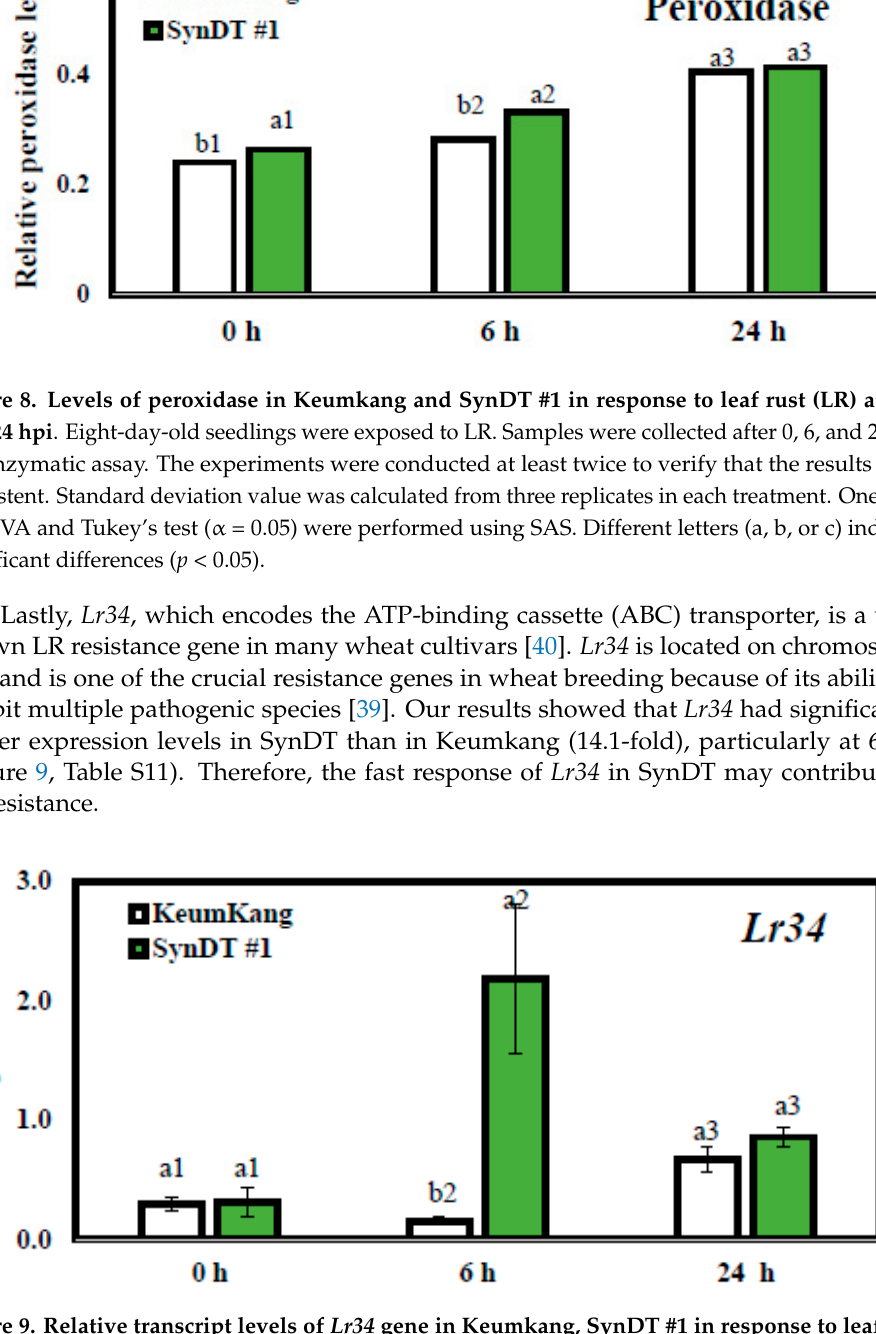
Figure 9. Relative transcript levels of Lr34 gene in Keumkang, SynDT #1 in response to leaf rust (LR) at 0, 6, and 24 hpi. Eight-day-old seedlings were exposed to LR. Samples were collected after 0, 6, and 24 hpi for RNA extraction and cDNA synthesis. Actin97 was used as internal control. The experiments were conducted at least twice to verify that the results were consistent. Standard deviation value was calculated from three replicates in each treatment. One-way ANOVA and Tukey’s test ( α = 0.05) were performed using SAS. Different letters (a, b, or c) indicate significant differences ( p < 0.05).